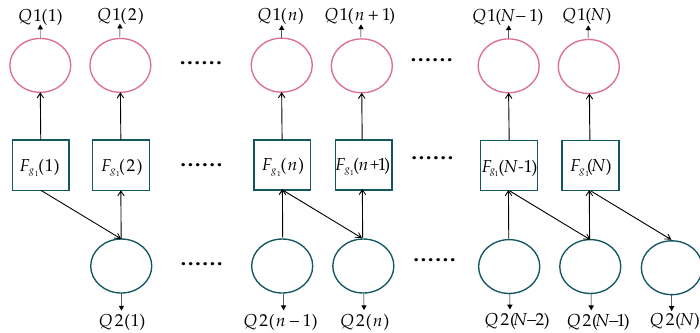
Figure 10. Node graph of the propagation process in SP-MPA.